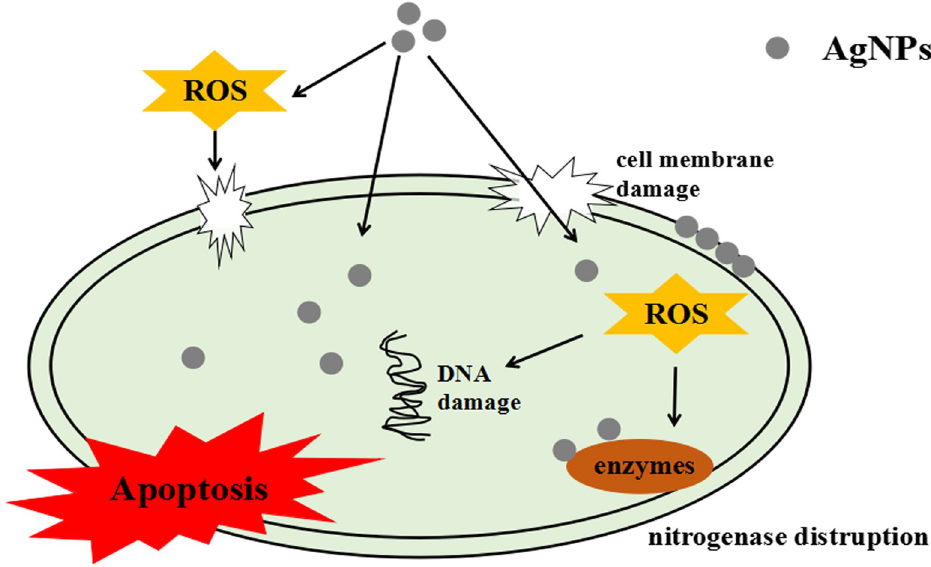
Fig 8. Possible toxicity mechanism for AgNPs in A . vinelandii